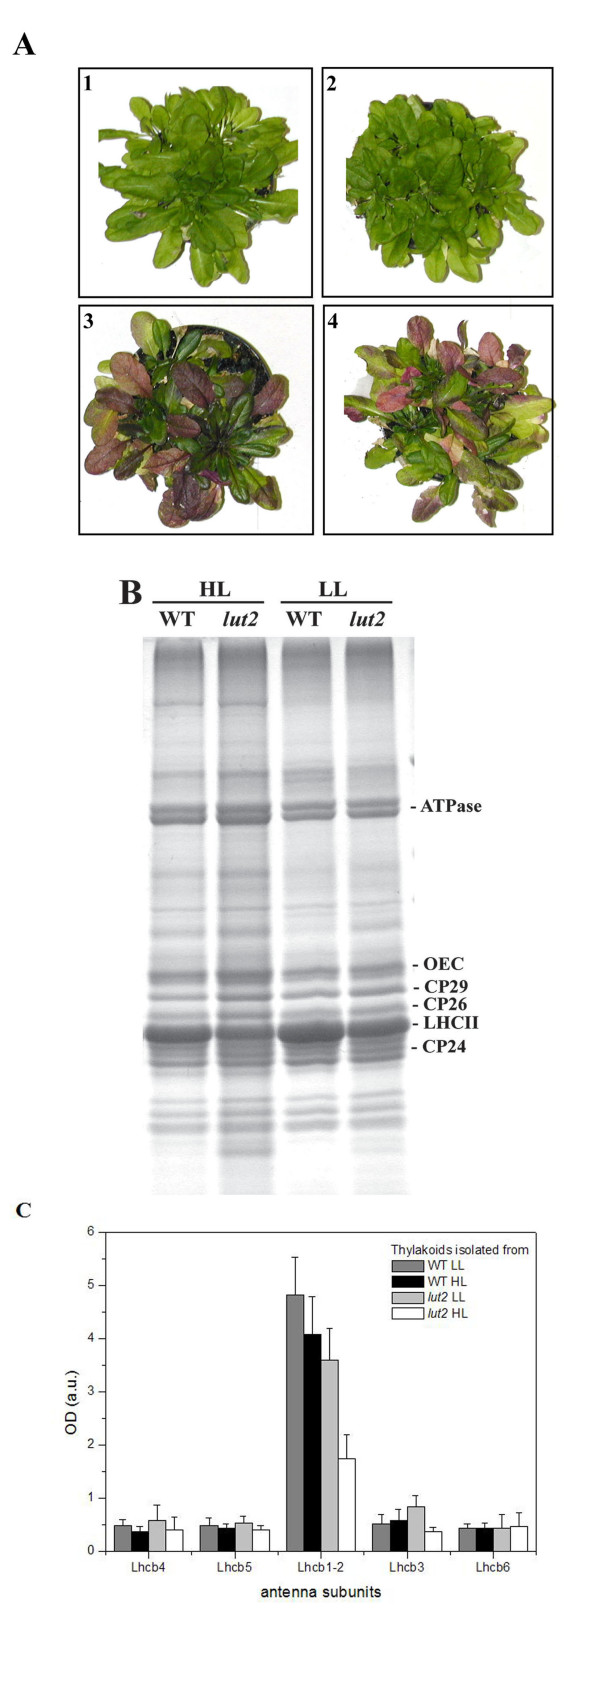
Phenotypes of WT and lut2.1 grown in normal and high light conditions. (A) Three-weeks-old WT (Fig. 1,3) and lut2.1 (Fig. 2,4) plants were grown for 3 additional weeks in normal light conditions (21°C, 120 μmol m-2 s-1 - LL) (Fig. 1,2) or in high light conditions (21°C, 1400 μmol m-2 s-1 - HL) (Fig. 3,4). (B) Tris-Tricine SDS-PAGE analyses of thylakoid from LL or HL plants. Main protein components are indicated. (C) Relative level of thylakoid antenna proteins evaluated by densitometry of bands identified by immunoblotting.